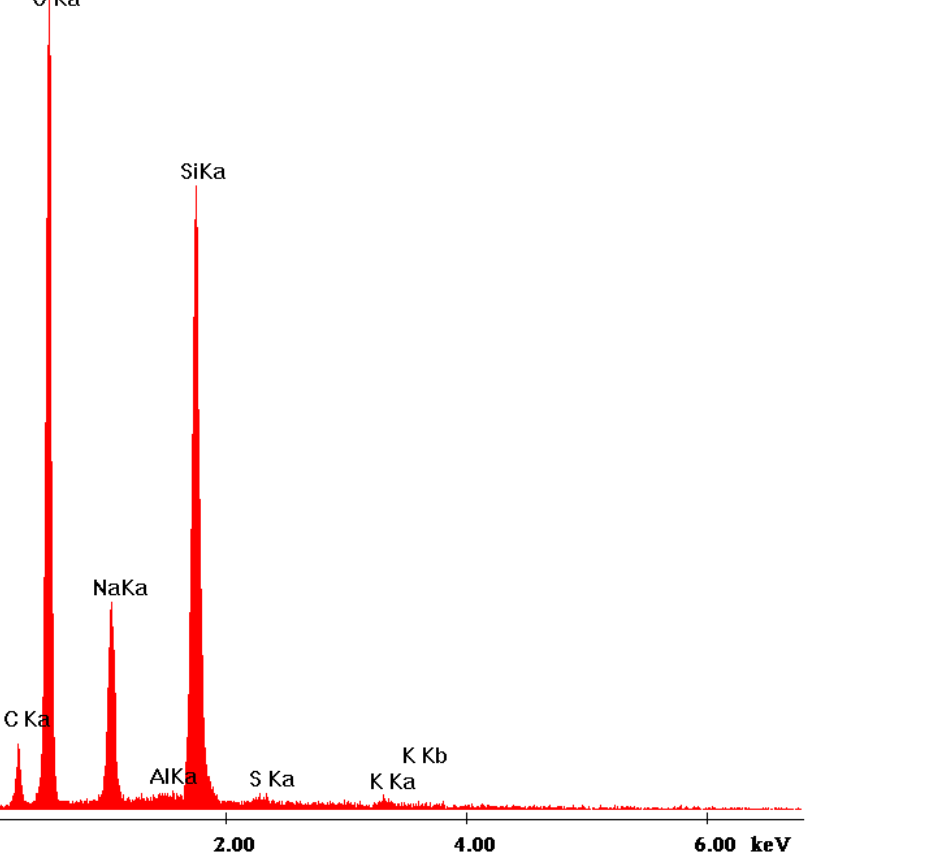
Figure 15. EDS analysis of the 1:1 mass ratio of the sodium water glass to the sodium polyacrylate.